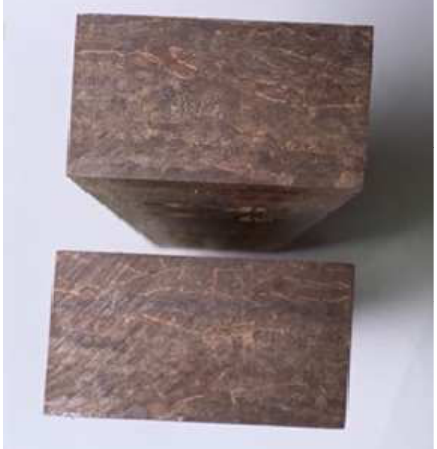
Figure 1. Parallel Strand Bamboo Cross Section.